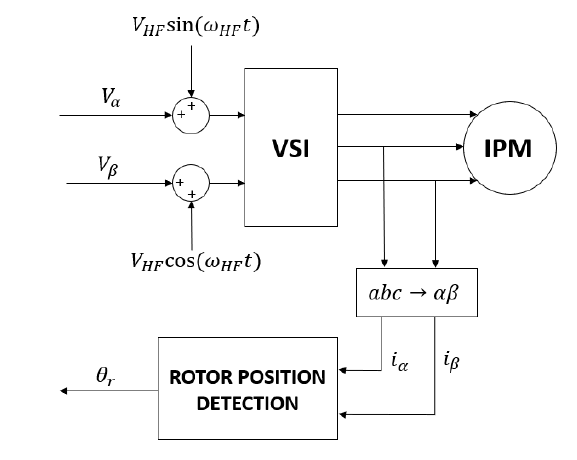
Figure 1. Signal injection working principle.